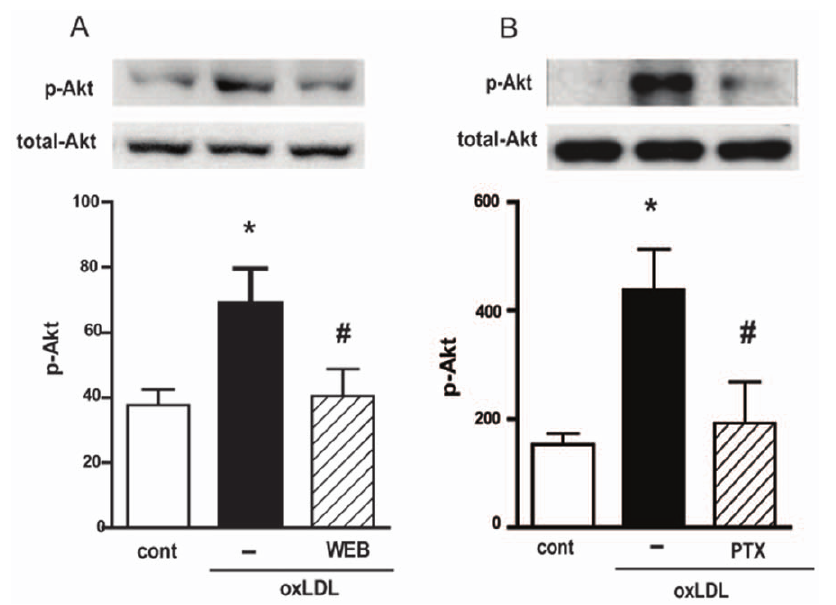
Figure 1. oxLDL activates the PI3k/Akt pathway in a PAFR and G a i coupled protein-dependent manner. Adherent monocytes/ macrophages were treated with WEB2170 (50 m M, 30 min) (A) or PTX (600 ng/mL, 18 h) (B) and stimulated with oxLDL (30 m g/mL) for 10 min. Western blot analysis of cell lysates were performed using antibodies to phosphorylated and non-phosphorylated forms of Akt. Data are presented as mean 6 SEM of four donors. Protein expression was quantified by the AlphaEaseFC TM software V3.2 beta (Alpha Innotech). The autoradiographs show one representative experiment. * p , 0.05 comparing oxLDL-stimulated with the non-stimulated cells (cont). # p , 0.05 comparing cells treated with WEB2170 or PTX with non-treated cells.